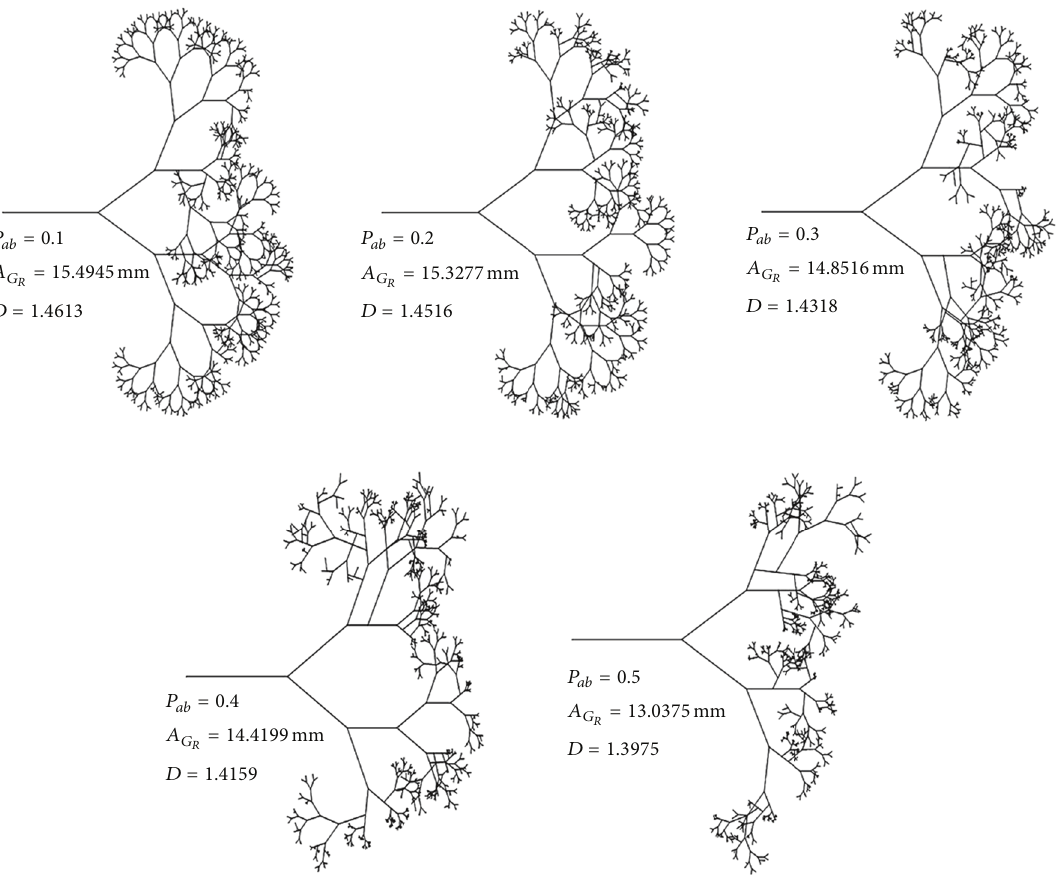
Figure 3: Trees generated with different probabilities in 𝑎 𝑏 and 𝑎 𝑝 (where 𝑃 𝑎𝑝 = 1 − 𝑃 𝑎𝑏 ), mean width 𝐴 𝐺